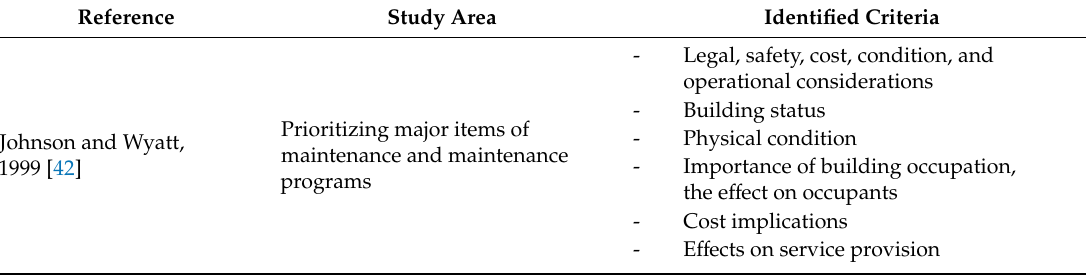
Table 1. Examples of the criteria in the